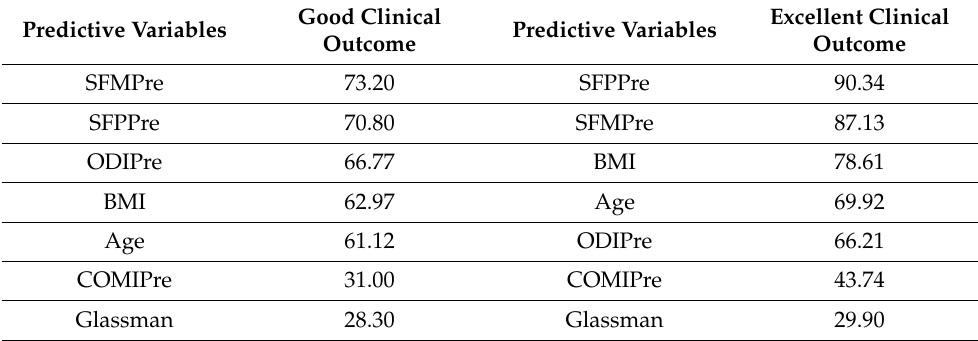
Table 4. Mean decreased Gini weights in good and excellent clinical outcomes.